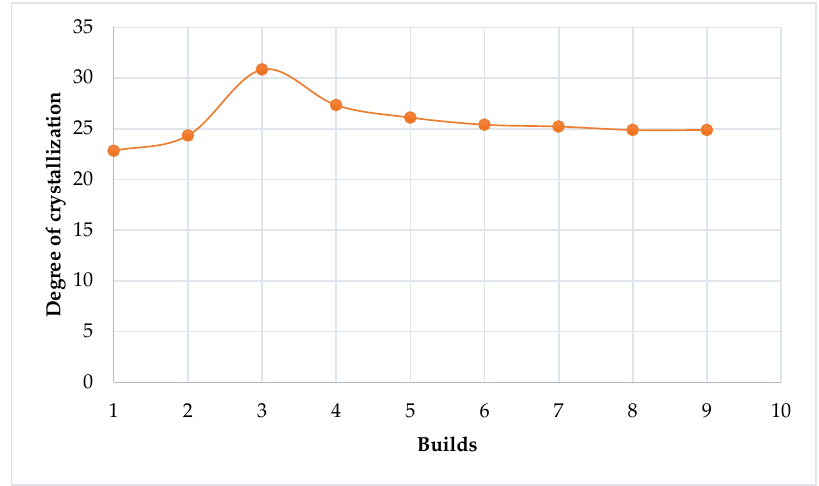
Table 7. Changes of a degree of crystallization of Laser PP CP 75 after eight re ‐ use cycles.